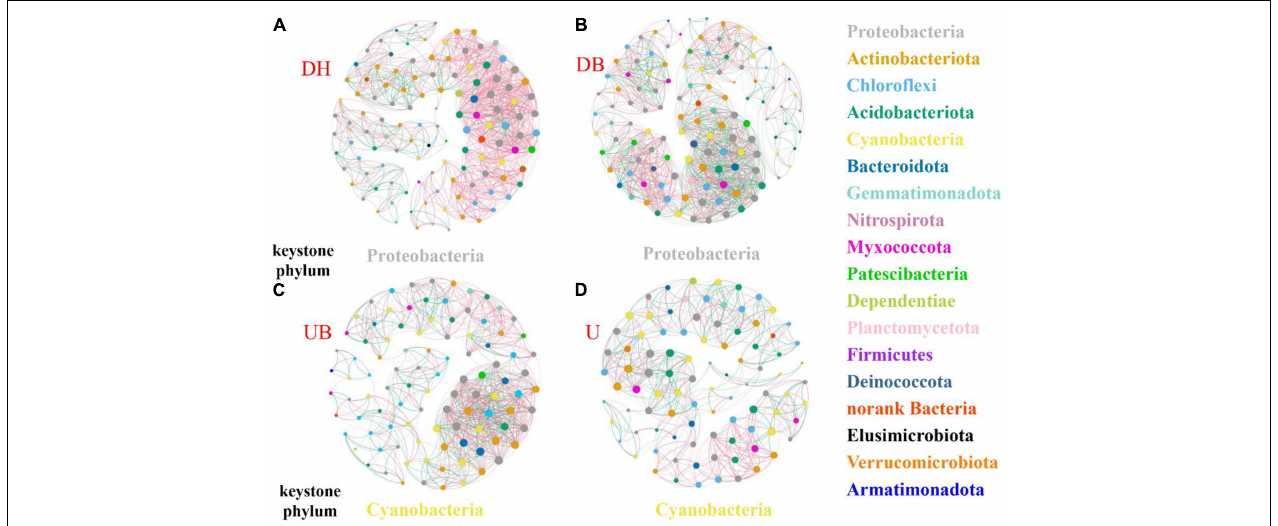
FIGURE 6 | Co-occurrence networks of biocrusts bacterial communities in different disturbance biocrusts. (A) DH network. (B) DB network. (C) UB network. (D) U network. The nodes are colored by the phylum level. The size of each node is proportional to the node degree. The link between each pair of nodes represents positive (pink) and negative (green)